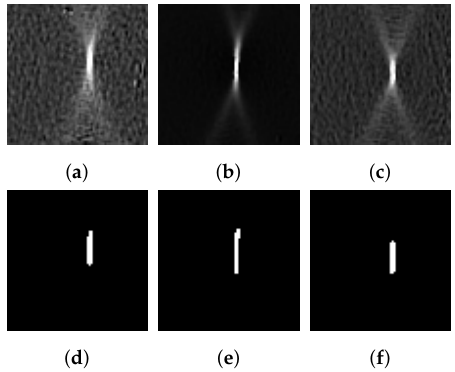
Figure 2. Difference strain images of DP800-S050-(1-3) ( a – c ) together with their corresponding segmentation masks ( d – f ). The black and white segmentation masks represent the corresponding parts of the difference strain images that characterize the local necking effect. White pixels indicate a contribution to the necking effect, whereas black pixels are considered as